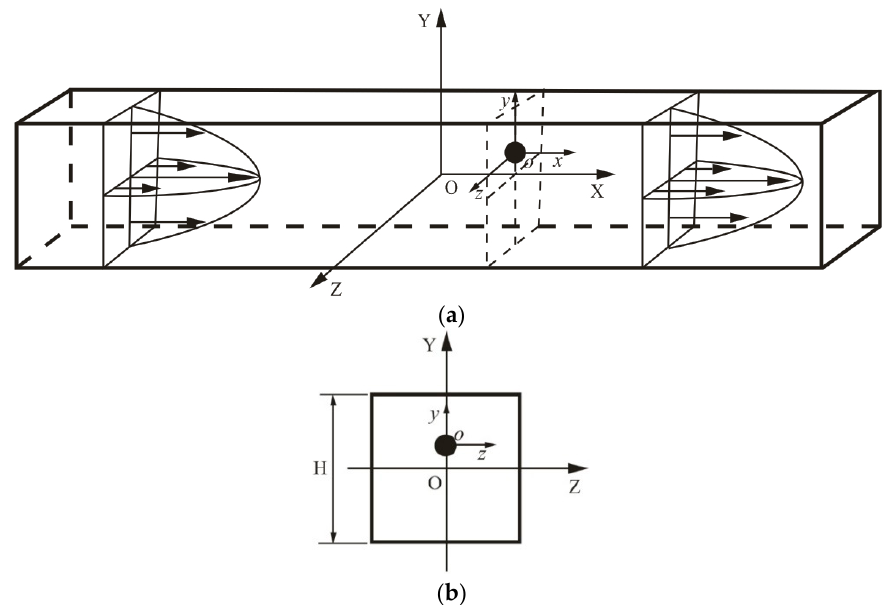
Figure 1. A sketch of a spherical particle in a channel flow. ( a ) a side view and ( b ) a left view.